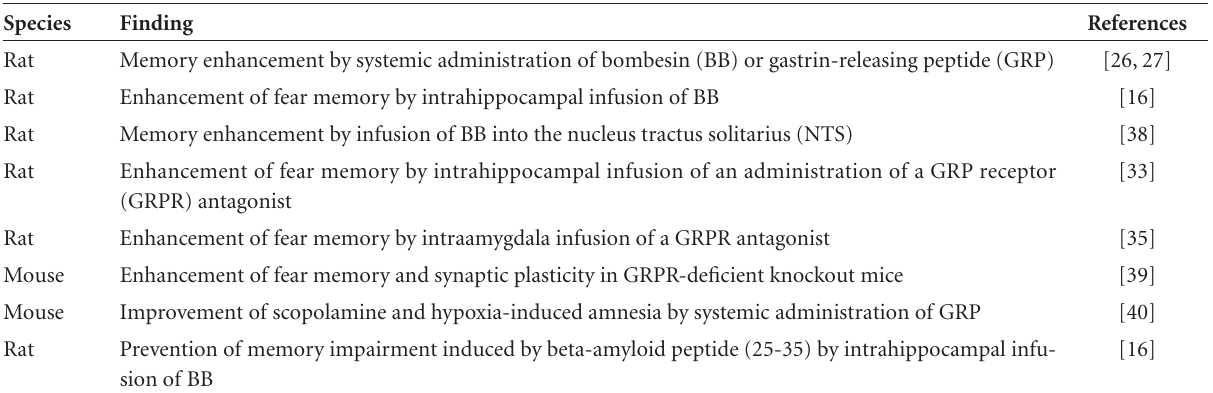
Table 3. Findings from preclinical studies indicating that drugs acting at the gastrin-releasing peptide receptor (GRPR) can display cognitive-enhancing